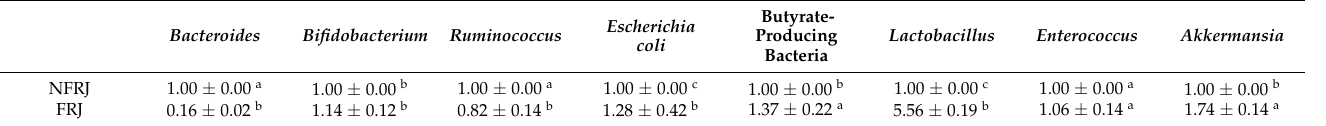
Table 2. The relative abundance of fecal microbiota with FRJ and NFRJ treatment.